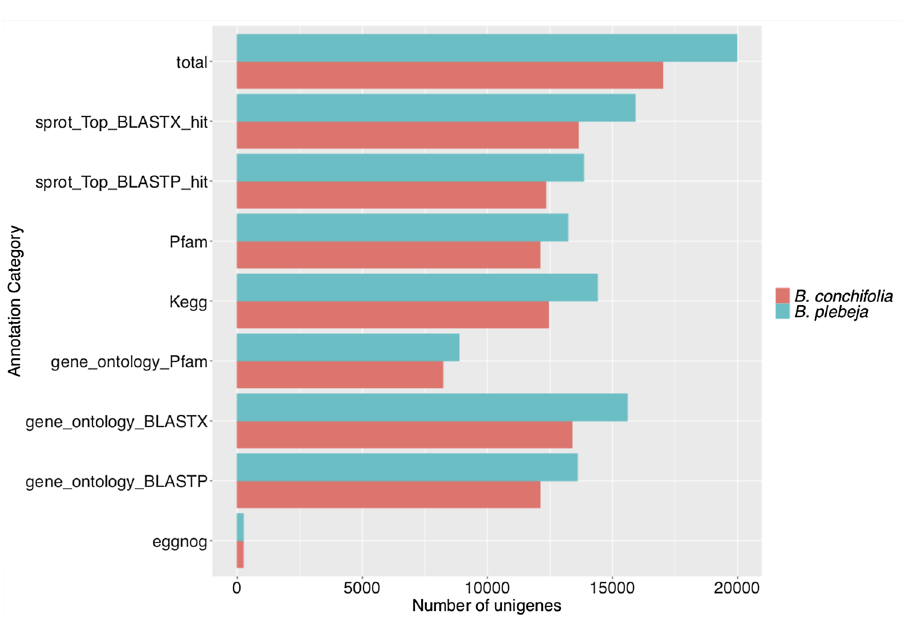
Figure 3. Number of unigenes annotated using different annotation categories in B. conchifolia and B. plebeja